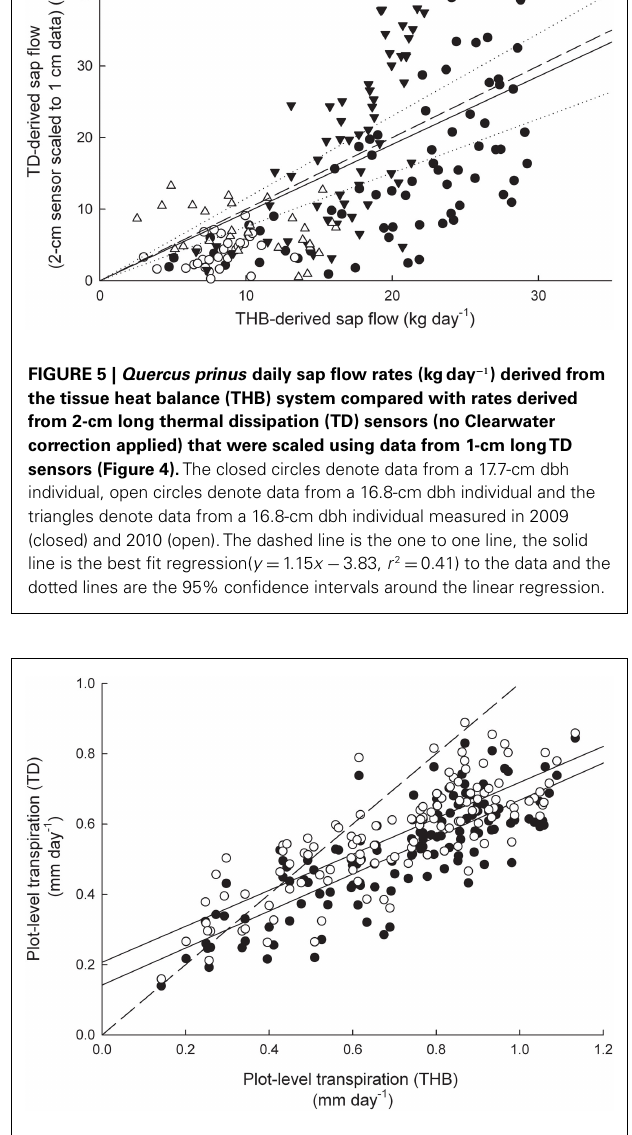
As long as a sufficient sample sizes are measured, sap flow rates measured with 1-cm long TD sensors should yield similar results as data measured with the THB system in Q. prinus ( Figure 5 ).